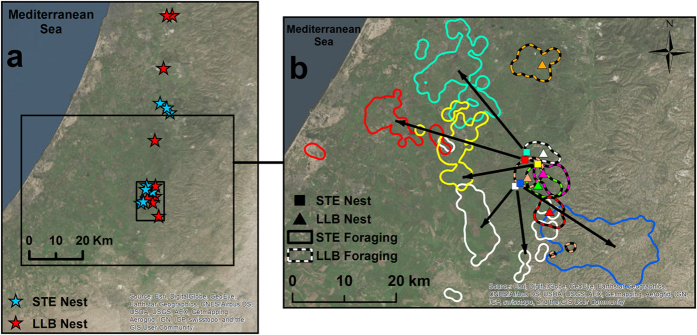
(a) Nest location of all tagged raptors (LLB n = 9, STE n = 8) at the entire study area. (b) Foraging areas (defined by a 95% KDE with a constant smoothing factor of 500 m) of 5 STEs and 6 LLBs. Note that 10 of the nests (marked inside the small rectangle in a) were located close to each other and that LLBs tended to forage close to their nests (2.35 ± 0.62 km), while STEs used “flight corridors”, represented by black arrows, to access their far foraging areas located at a mean distance of 13.03 km (±2.20) from their nests and at different geographical areas. These figures were generated by using GIS software - ArcGIS (ESRI. 10.1).